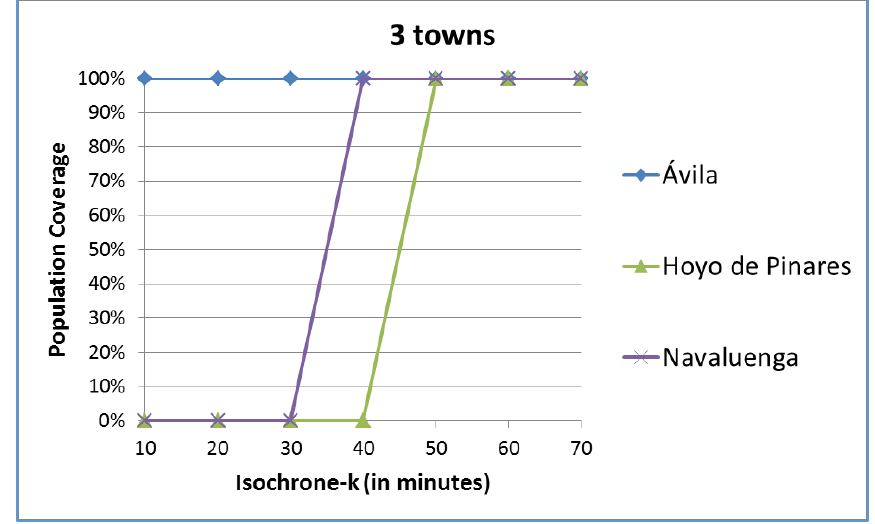
Figure 5. Coverage of three towns of the province of